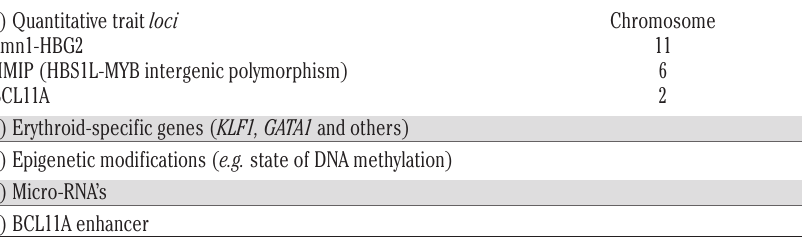
Table 2. Determinants of hemoglobin F